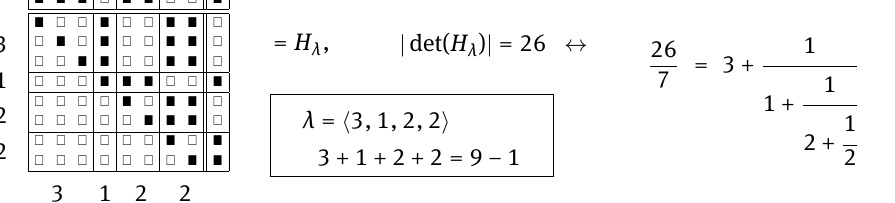
Figure 3: The matrix H λ for a composition λ = (cid:104) λ 1 , . . . , λ k (cid:105) of n − 1 with first and last parts larger than one, and its determinant as numerator of the continued fraction [ λ 1 ; λ 2 , . . . , λ